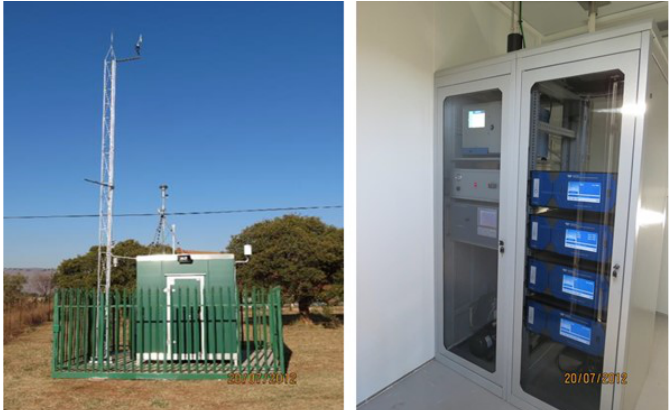
Figure 2. A typical air quality station in South Africa along with a photo of the air quality instruments [40].